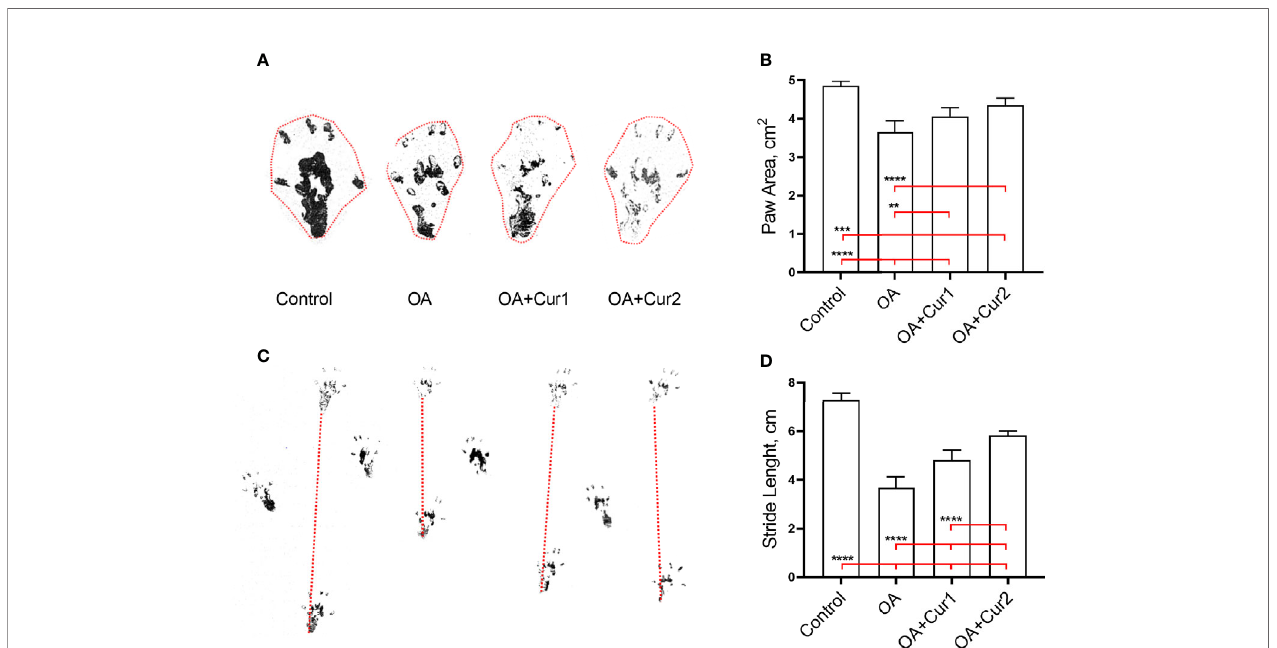
FIGURE 4 | Effects of Next Generation Ultrasol Curcumin (NGUC) supplementation on paw area and stride length in rats with monosodium iodoacetate (MIA)- induced OA. (A) Representative measurement of paw area. (B) Graph shows paw area presented as cm 2 in indicated group of rats. (C) Representative measurement of stride length. (D) Graph shows stride length presented as cm in indicated group of rats. The data are presented as means ± SD (n=7 for each group). Statistical differences among the groups were determined by one-way ANOVA followed by a post-hoc Tukey test; ** p < 0.01, *** p < 0.001, **** p < 0.0001.